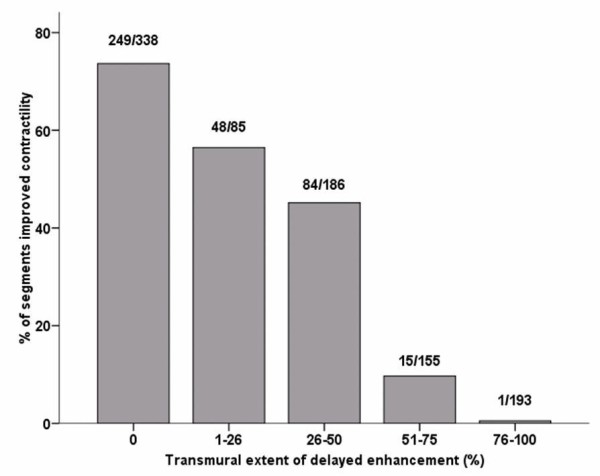
Relationship between the transmural extent of scar and functional recovery on a segmental basis.